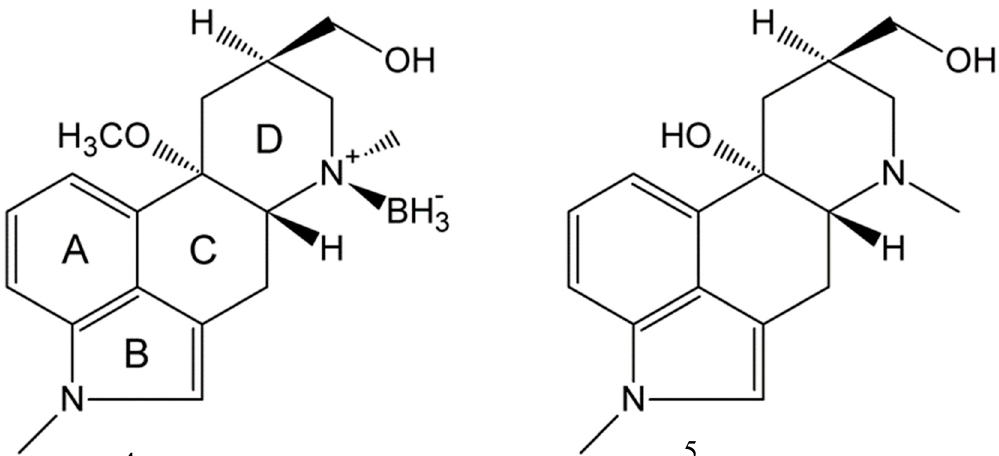
Figure 2. Scheme of BH 3 -MeLuol complex ( 4 ) and Luol ( 5 ).